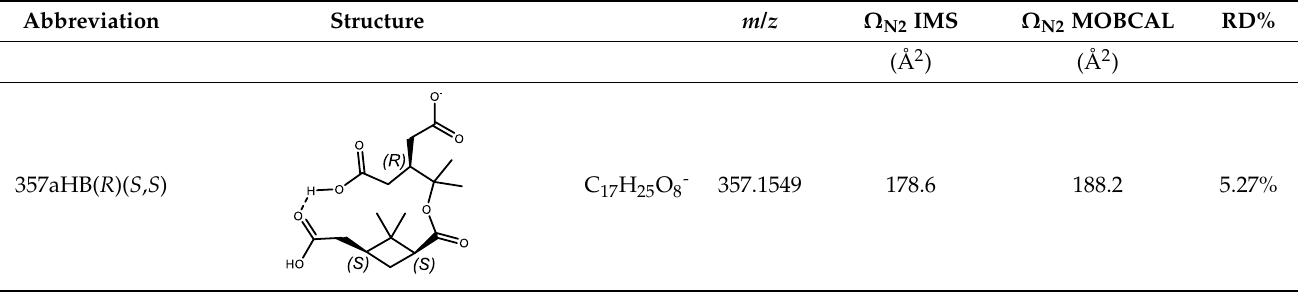
Table 4. Structures and Ω N values of m / z 357 and m / z 367 ions with an intra-molecular hydrogen bond considered in this study. Table 4. Structures and Ω N2 values of m / z 357 and m / z 367 ions with an intra-molecular hydrogen bond considered in this study. Table 4. Structures and Ω N2 values of m / z 357 and m / z 367 ions with an intra-molecular hydrogen bond considered in this study. 2 Table 4. Structures and Ω N2 values of m / z 357 and m / z 367 ions with an intra-molecular hydrogen bond considered in this study. Table 4. Structures and Ω N2 values of m / z 357 and m / z 367 ions with an intra-molecular hydrogen bond considered in this